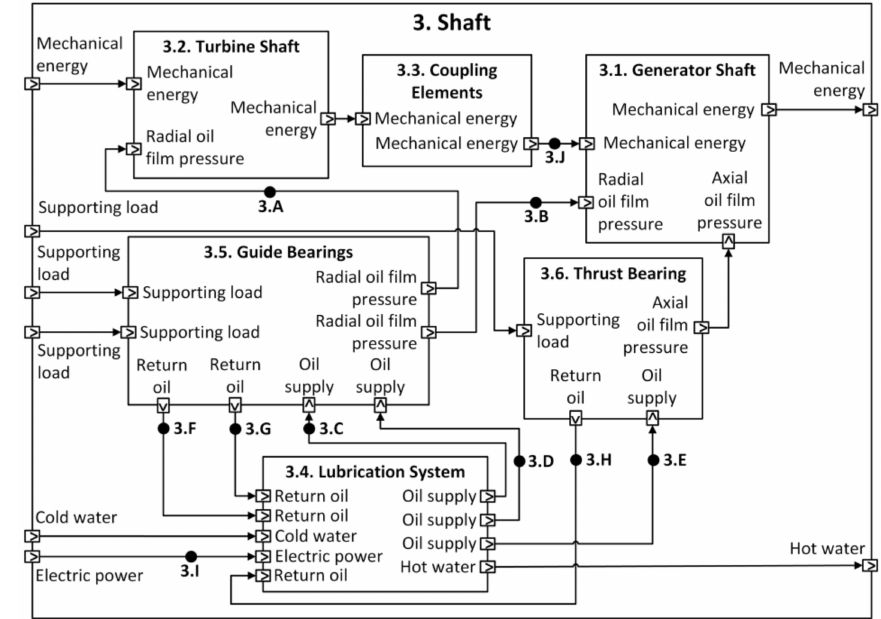
Figure 4. Shaft Internal Block Diagrams (IBD) with the representation of interfaces and information flow between the components of this